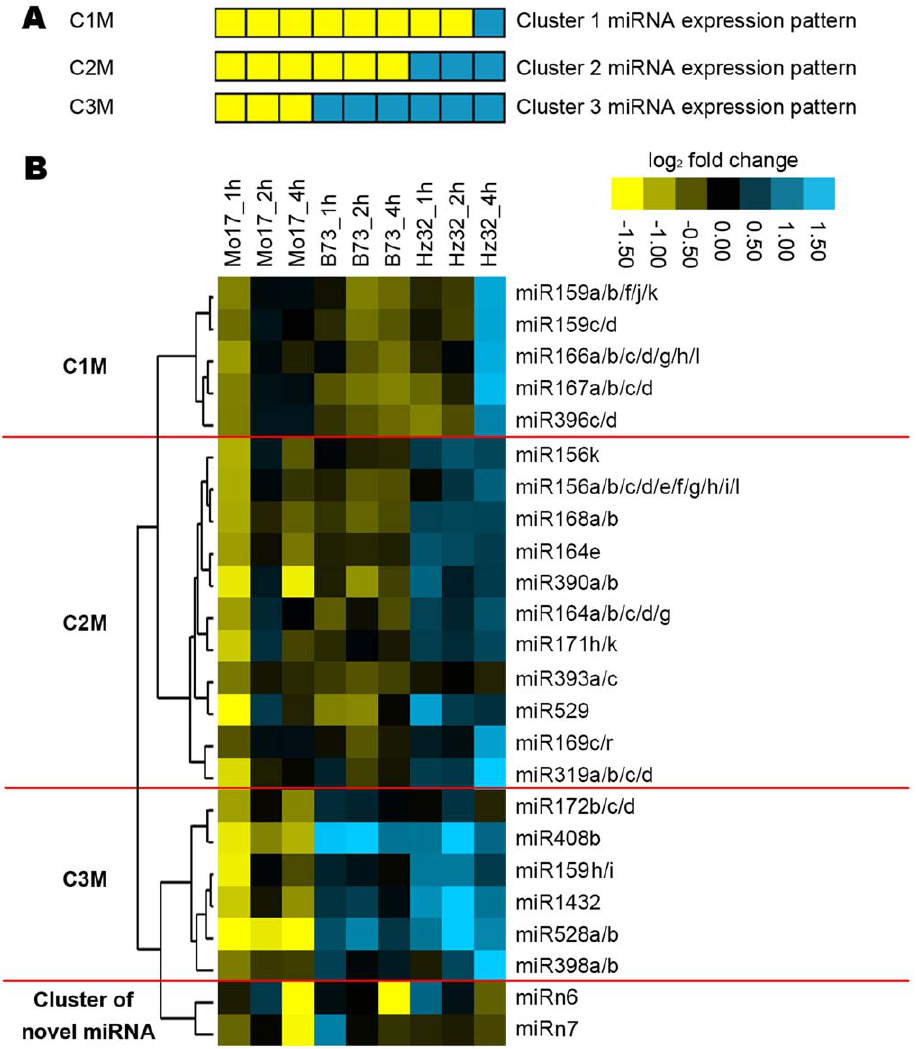
Figure 5. miRNA expression profile by SLRT-PCR and cluster analysis. A: Model of miRNA expression pattern. B: Heatmap of miRNA expression profile. The cluster was done on the basis of log 2 (expression level in treatment/expression level in control). Yellow shows down- regulation. Blue shows up-regulation.